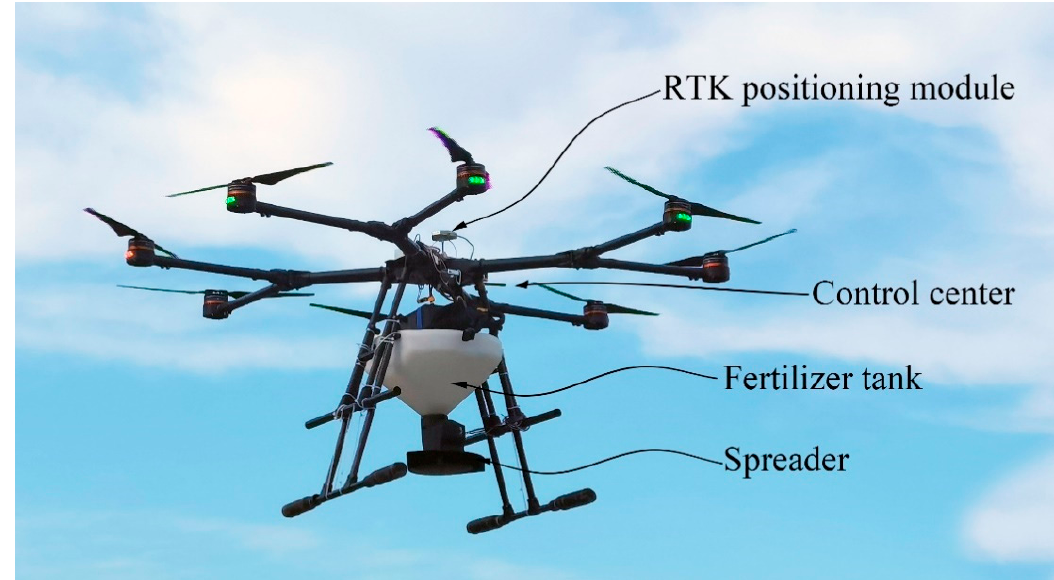
Figure 1. UAV variable fertilizer application system.